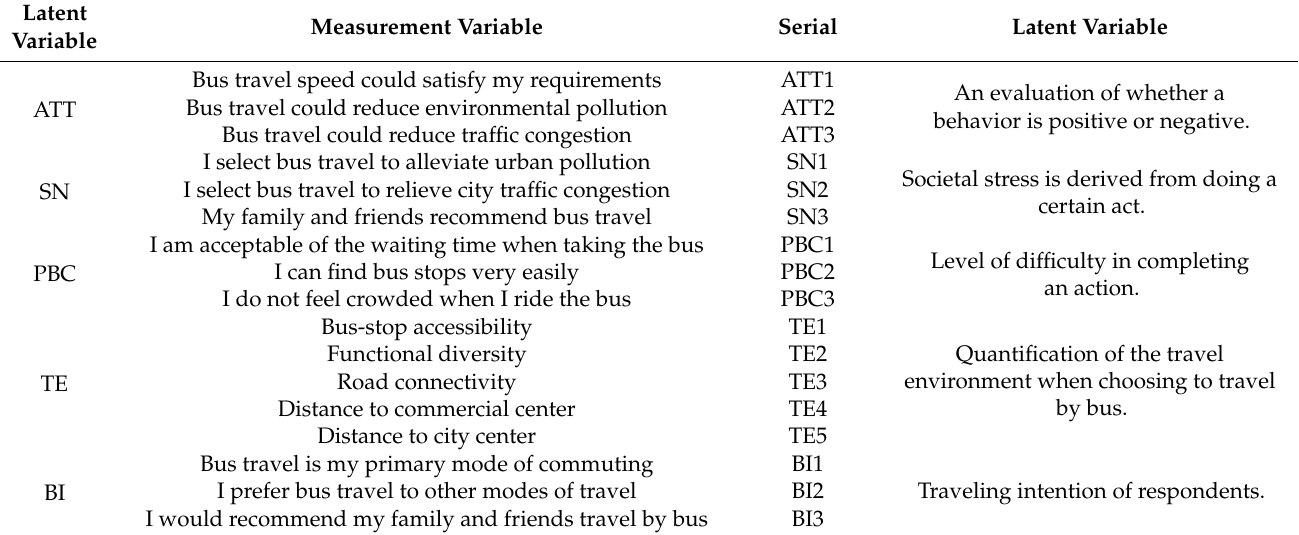
Table 1. Description of measurement